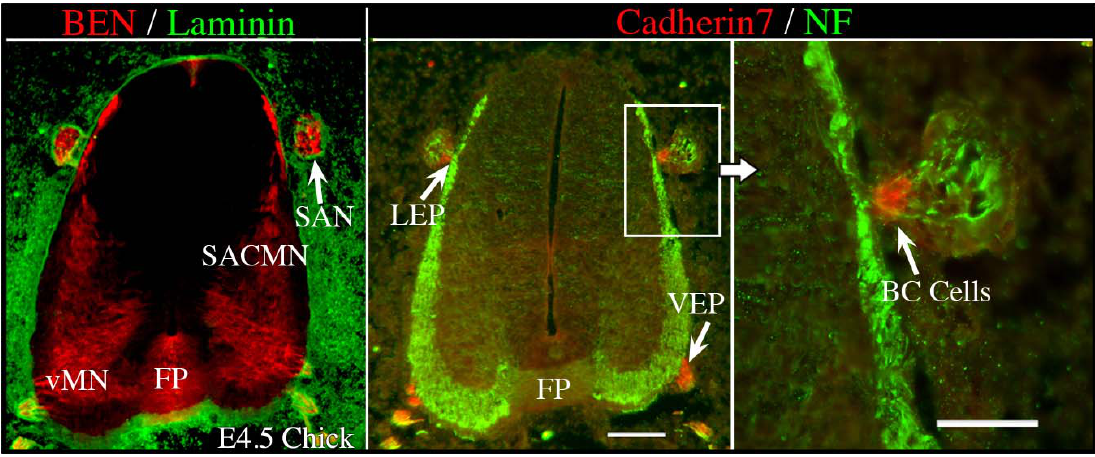
Figure 2. Cadherin 7-expressing BC cells are located at both the lateral and ventral exit points in chick embryos. Cervical spinal cord-containing transverse cryosections derived from E4.5 chick embryos were doubled-labeled with either anti-Ben and anti-Laminin ( Left ) or anti-Cadherin 7 and anti-NF ( Middle , Right ), and the appropriate secondary antibodies. ( Left ) BEN is expressed by both SACMN and vMN at this developmental stage, the FP and the SAN, which is positioned outside and adjacent to the spinal cord. Anti-Laminin labeling demarcates the margin of the spinal cord. ( Middle ) Cadherin 7-expressing BC cells are located at both the LEP and VEP. In this panel, the SAN is labeled by anti-NF. ( Right ) A higher magnification view of the boxed area in the middle panel. SACMN, spinal accessory motor neurons; SAN, spinal accessory nerve; vMN, ventral motor neurons; FP, floor plate; LEP, lateral exit point; VEP, ventral exit point; BC cells, boundary cap cells. Scale bar in middle panel, 100 μ m, applies to the left and middle panels. Scale bar in right panel, 50 μ